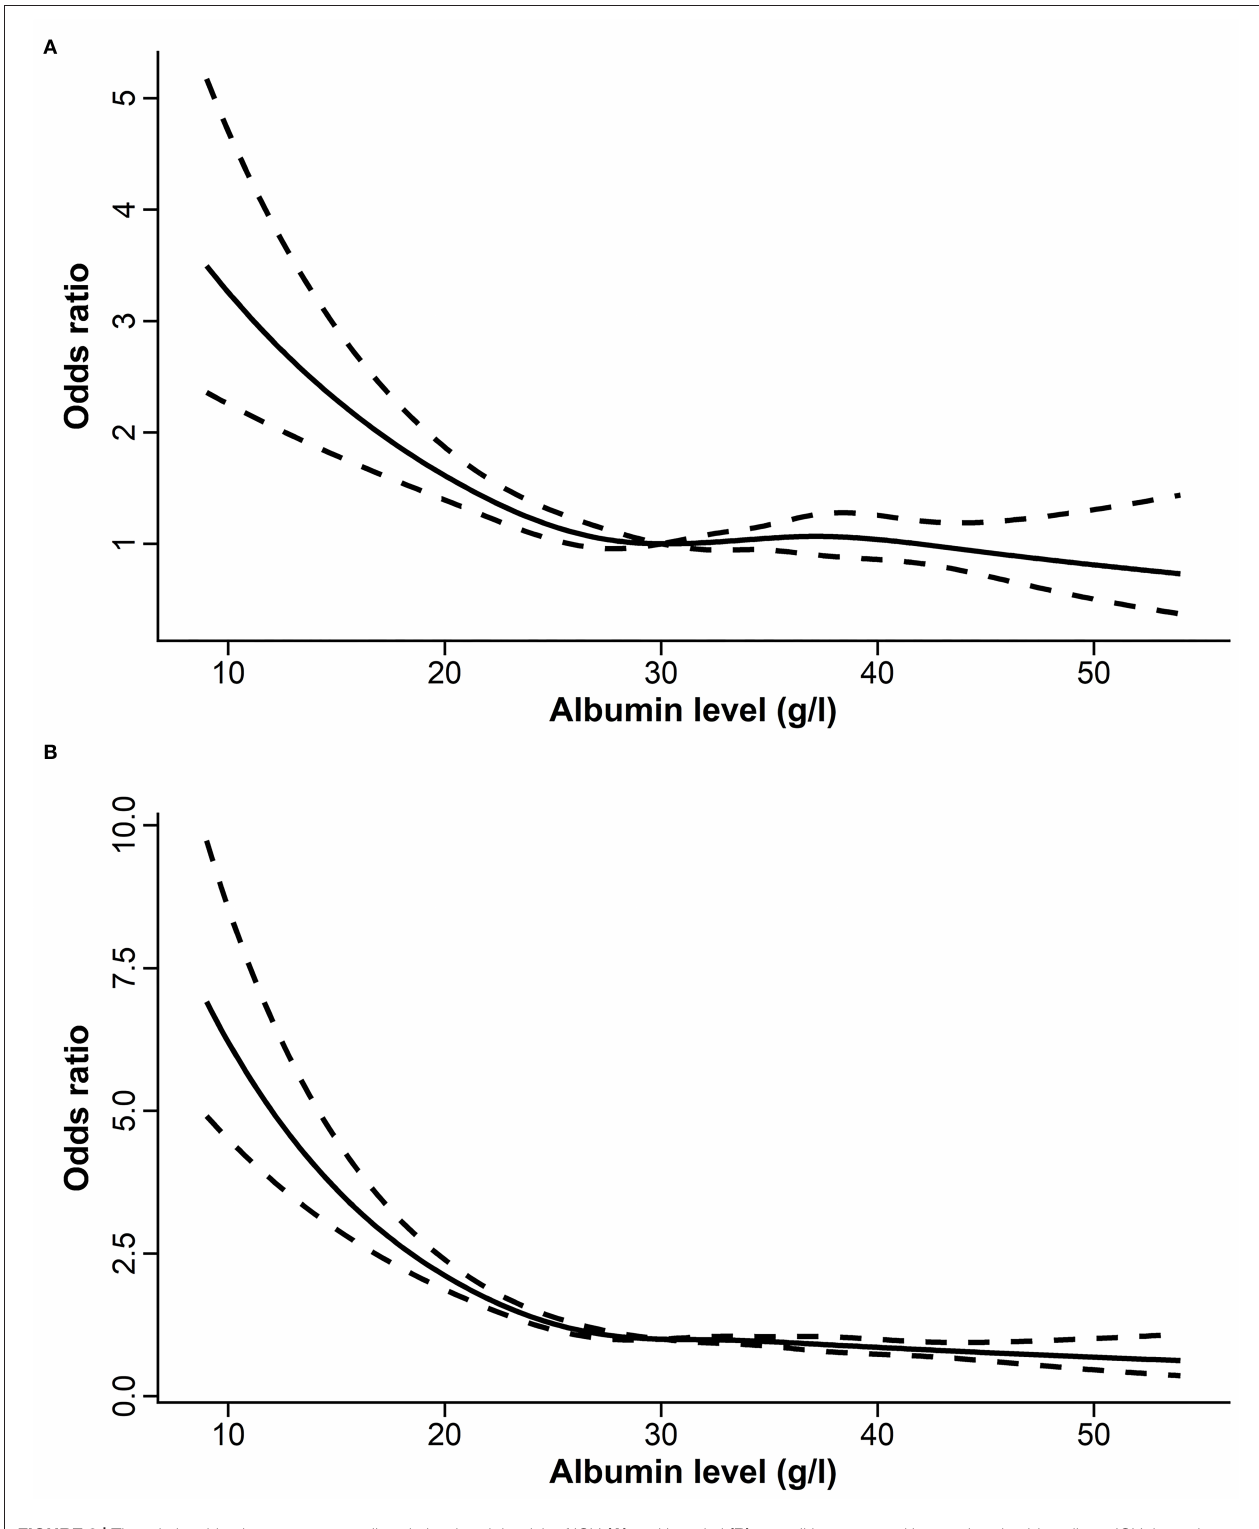
Frontiers in Nutrition |